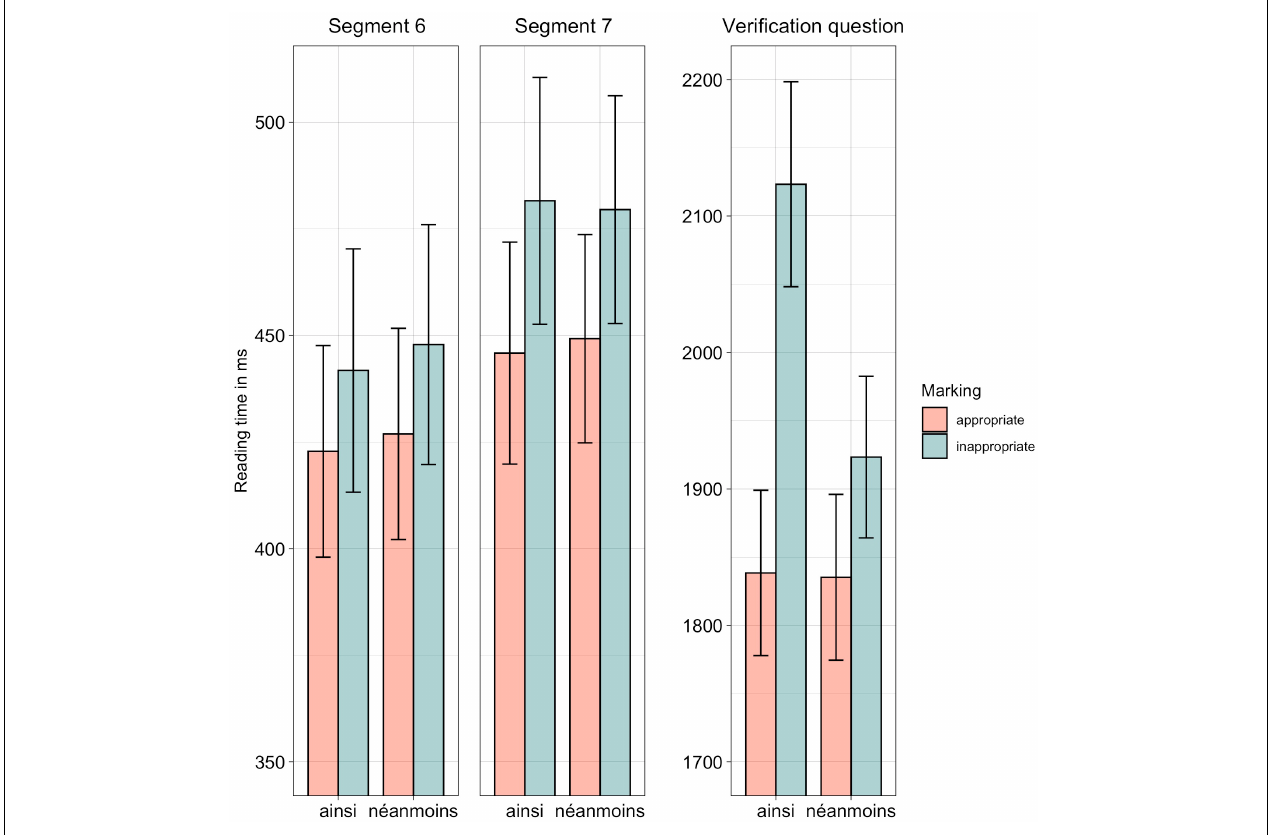
FIGURE 2 | Experiment 2, reading times for Segments 6 and 7 as well as response times to the verification question. CI of 95% as error